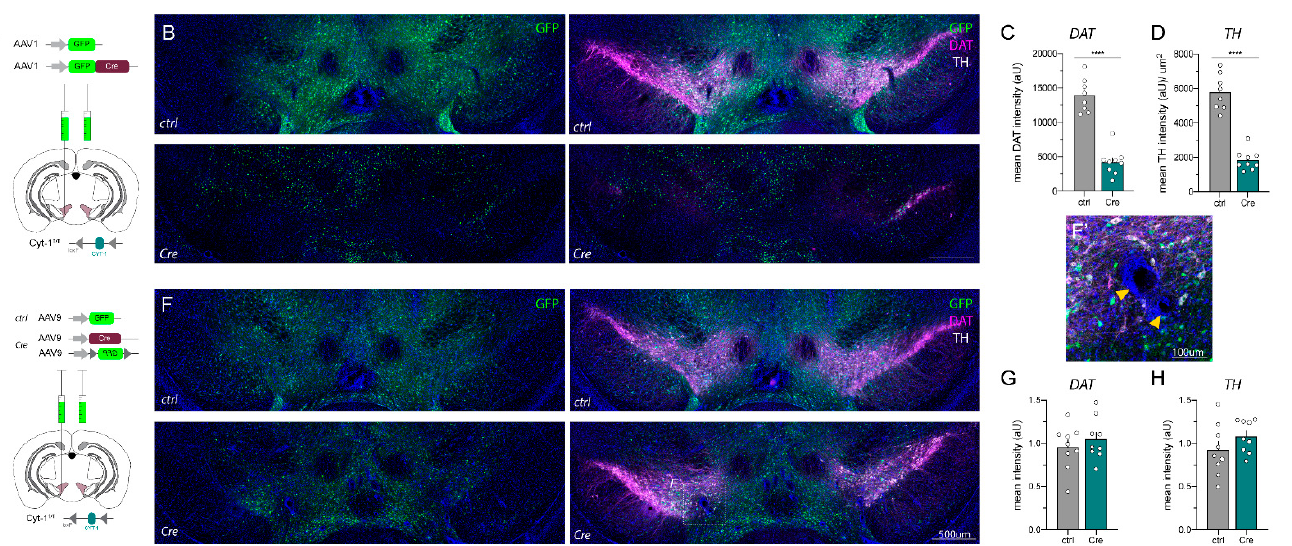
Figure 3. Loss of key dopamine regulatory proteins and appearance of lesions after AAV_Cre injections into the VTA of ErbB4 Cyt-1 fl/fl mice. ( A , E ) Schematic depiction of microinjections of AAV1 and AAV9 serotypes driving expression of either Cre-recombinase, GFP-tagged Cre or GFP controls (all at 10 13 GC/mL) into the VTA of adult ErbB4 Cyt-1 fl/fl mice. ( B ) AAV1_Cre-GFP injection cause a dramatic loss of DAT (magenta) and TH (white) protein in the mesencephalon after four weeks, quantified in ( C , D ) as mean intensity (ctrl n = 8, Cre n = 9; unpaired t -test, p < 0.0001 ****). ( F ) Immunohistochemical visualization of AAV9_Cre/AAV9_DIO-GFP injections show unaltered protein levels. ( F’ ) Magnification of DAPI-negative holes in AAV9_Cre injected mice. ( G , H ; ctrl n = 9, Cre n = 9; unpaired t-test, DAT p = 0.4419, TH p = 0.1922), but cause nuclei (DAPI)-negative lesions in the mesencephalon. Scale bars 500 µm in ( B , F ) and 100 µm in ( F’ ).